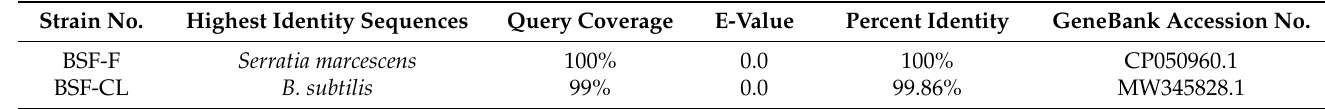
Table 2. Intestinal microorganisms of BSF larvae against S. aureus , E. coli , and Salmonella . Strain